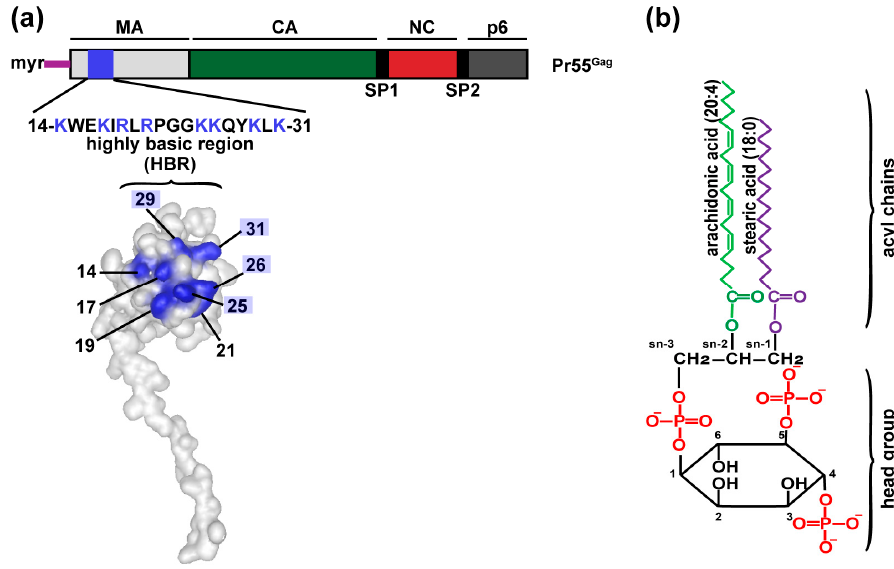
Figure 1. Cartoons depicting HIV-1 Gag MA-HBR, and PI(4,5)P2. ( a ) Schematic illustration of HIV-1 Gag with the structure of HIV-1 MA (PDB accession number 2HMX) showing the basic residues of the MA-HBR in blue. The key basic residues studied in detail in our recent work [48] are indicated (in the nomenclature for MA amino acid residues used in this review, the first methionine removed upon myristylation is not counted). ( b ) Illustration of 38:4 PI(4,5)P2, the predominant molecular species of PI(4,5)P2 in many primary mammalian cells [49–53].